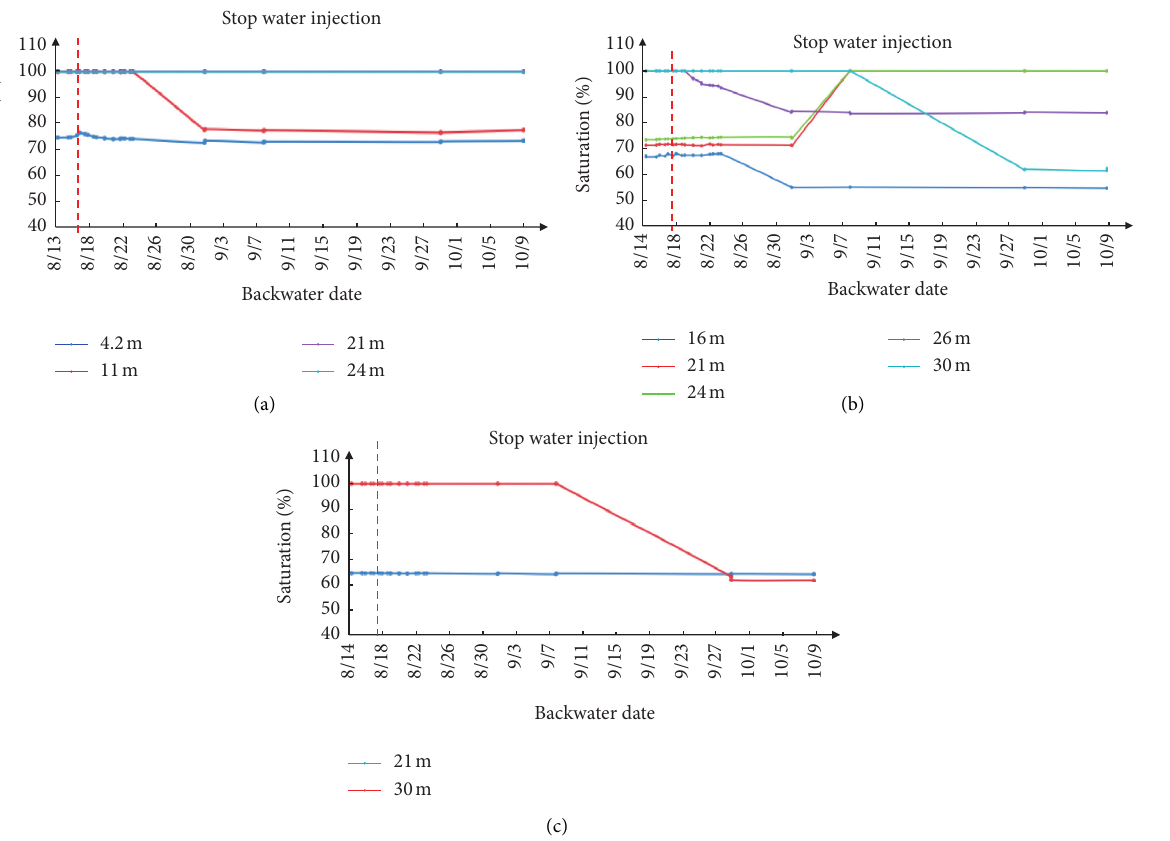
Figure 8: The soil saturation curve with backwater time: (a) exploratory well T1, (b) exploratory well T3, and (c) exploratory well T5.